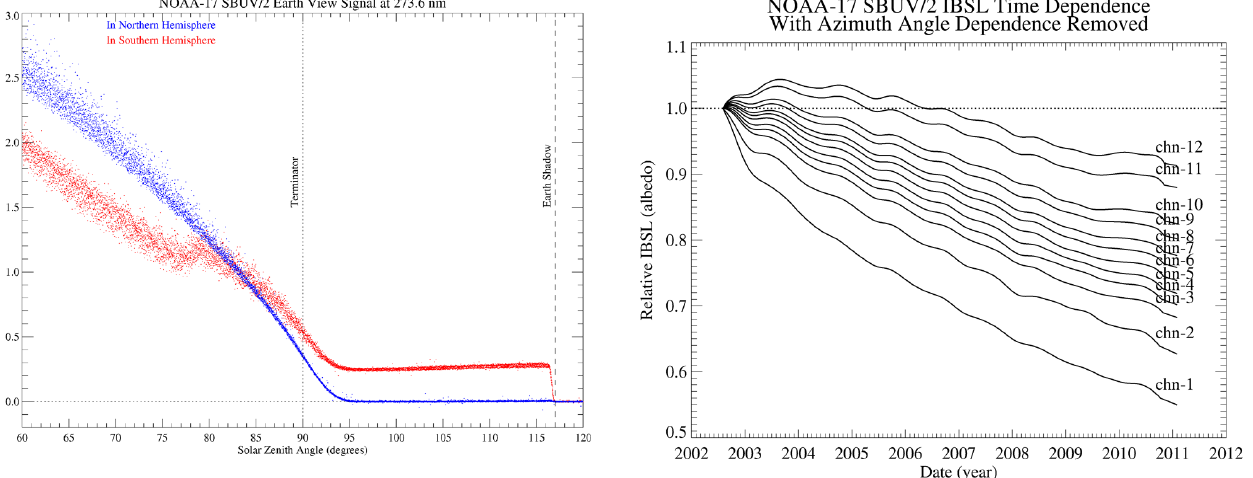
Fig. 19. Time dependence of linear slope (dIBSL/dSZA) night char- acterizing solar zenith angle dependence of NOAA-17 IBSL error on the night side. All values have been normalized to the initial re- sults derived in August 2002. The seasonal variation in slope due to orbital change has been